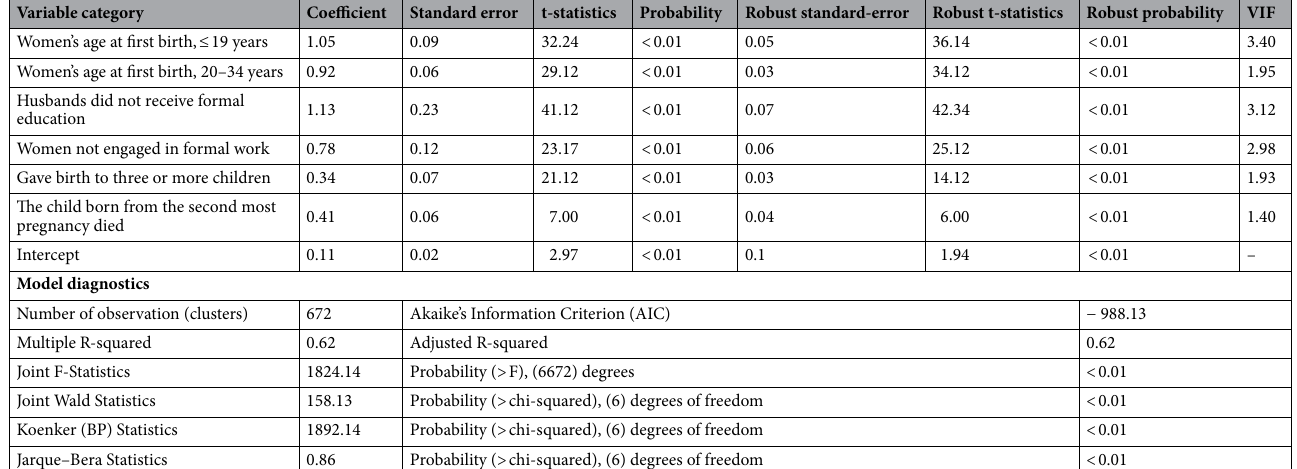
Table 3. Ordinary least square regression model identifying significant factors of short birth interval in Bangladesh, BDHS 2017/18.